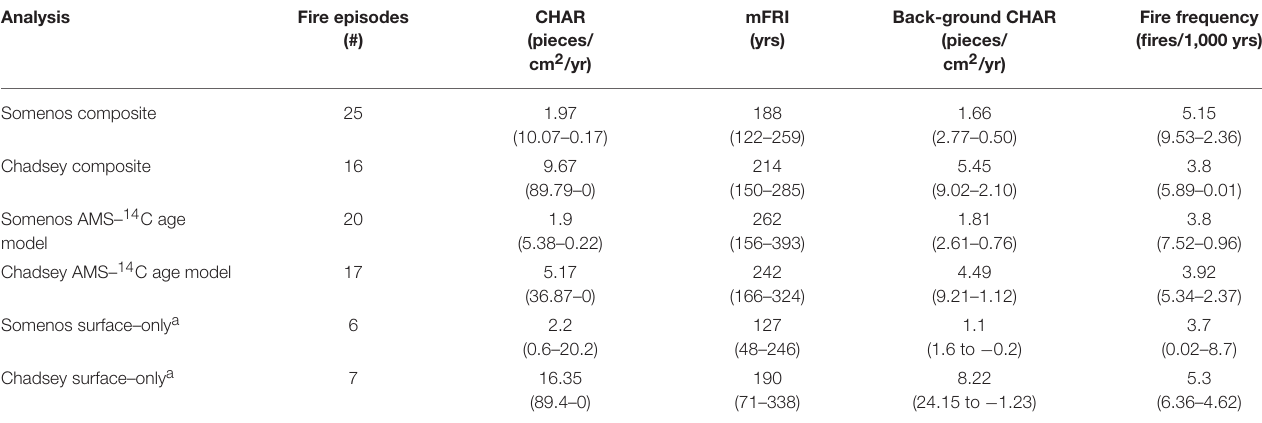
TABLE 1 | Fire history characteristics of Somenos and Chadsey Lakes over the last ∼ 5,000 years.